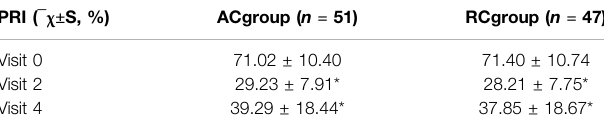
TABLE 4 | Comparison of PRI in different time periods for AC and RC in CI